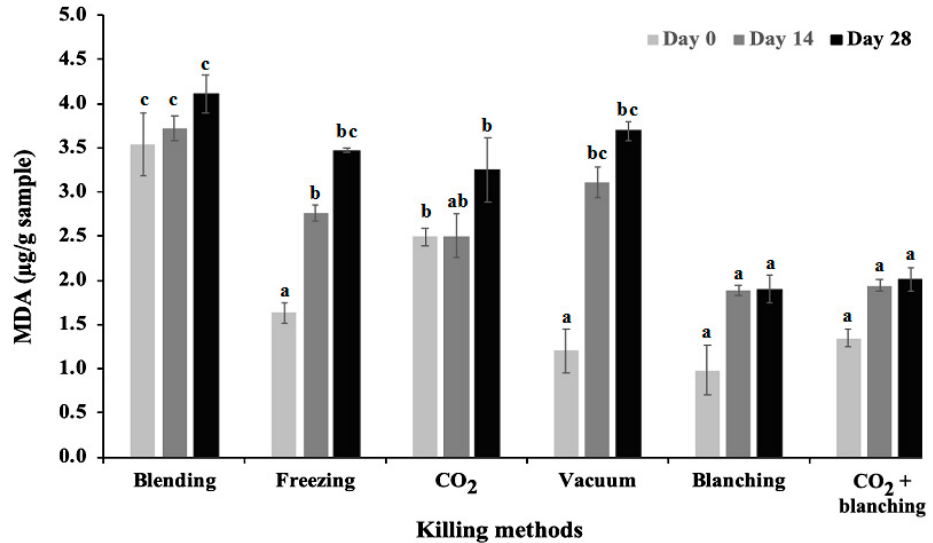
Figure 1. Storage time on thiobarbituric acid-reactive substance (TBAR) contents of BSFs after storage at 4 °C during 0 ( ), 14 ( ) and 28 days ( ). The differences on the superscript at the same day represent statistically significant differences between killing methods ( p < 0.05).